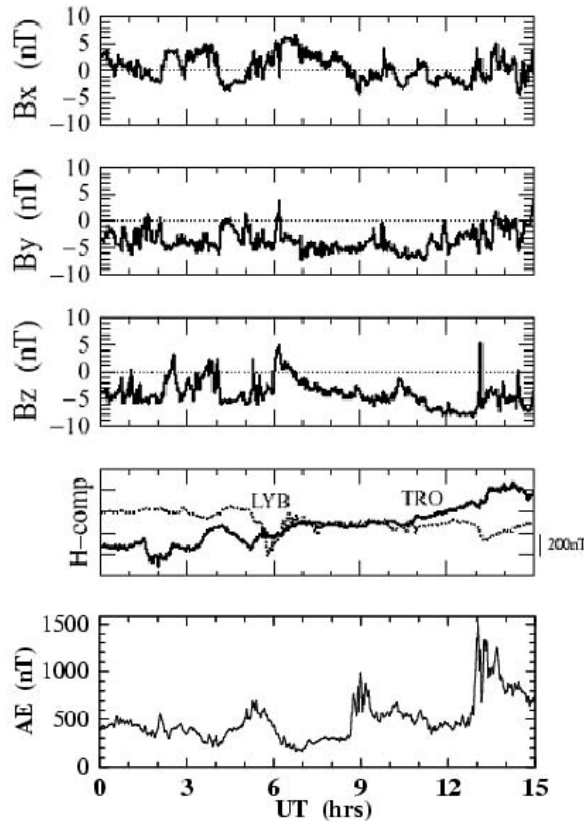
Fig. 1. The IMF B x , B y , and B z components measured by the WIND spacecraft upstream in the solar wind, H-component of the geomagnetic field at Tromsø (TRO) and Longyearbyen (LYB) and the quick-look AE index on 9 March 1999, from top to